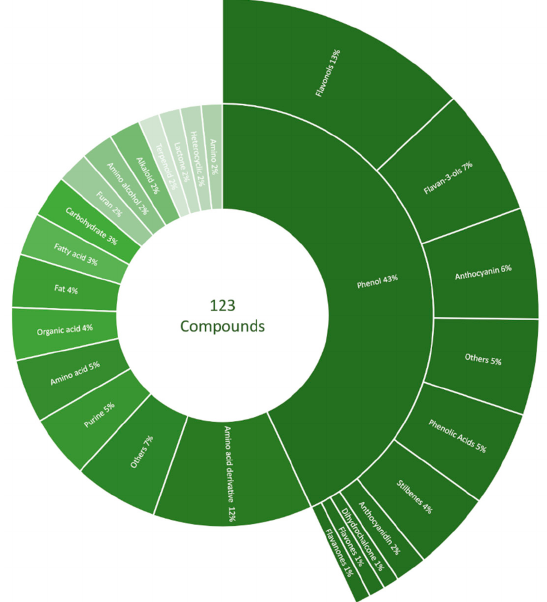
Figure 3. Percentage of putative annotation detected and identified by MassBank of North America (MoNA), METLIN, and Human Metabolome Database (HMDB) using LC-HRMS/MS. One hundred and twenty-three compounds were grouped into phenol, amino acid derivatives, others, purine, amino acid, organic acid, fat, fatty acid, carbohydrate, furan, amino alcohol, alkaloid, terpenoid, lactone, heterocyclic, and amino. Phenols were further divided into flavonols, flavan-3-ols, anthocyanin, others, phenolic acids, stilbenes, anthocyanidin, dihydrochalcone, flavones, and flavanones.